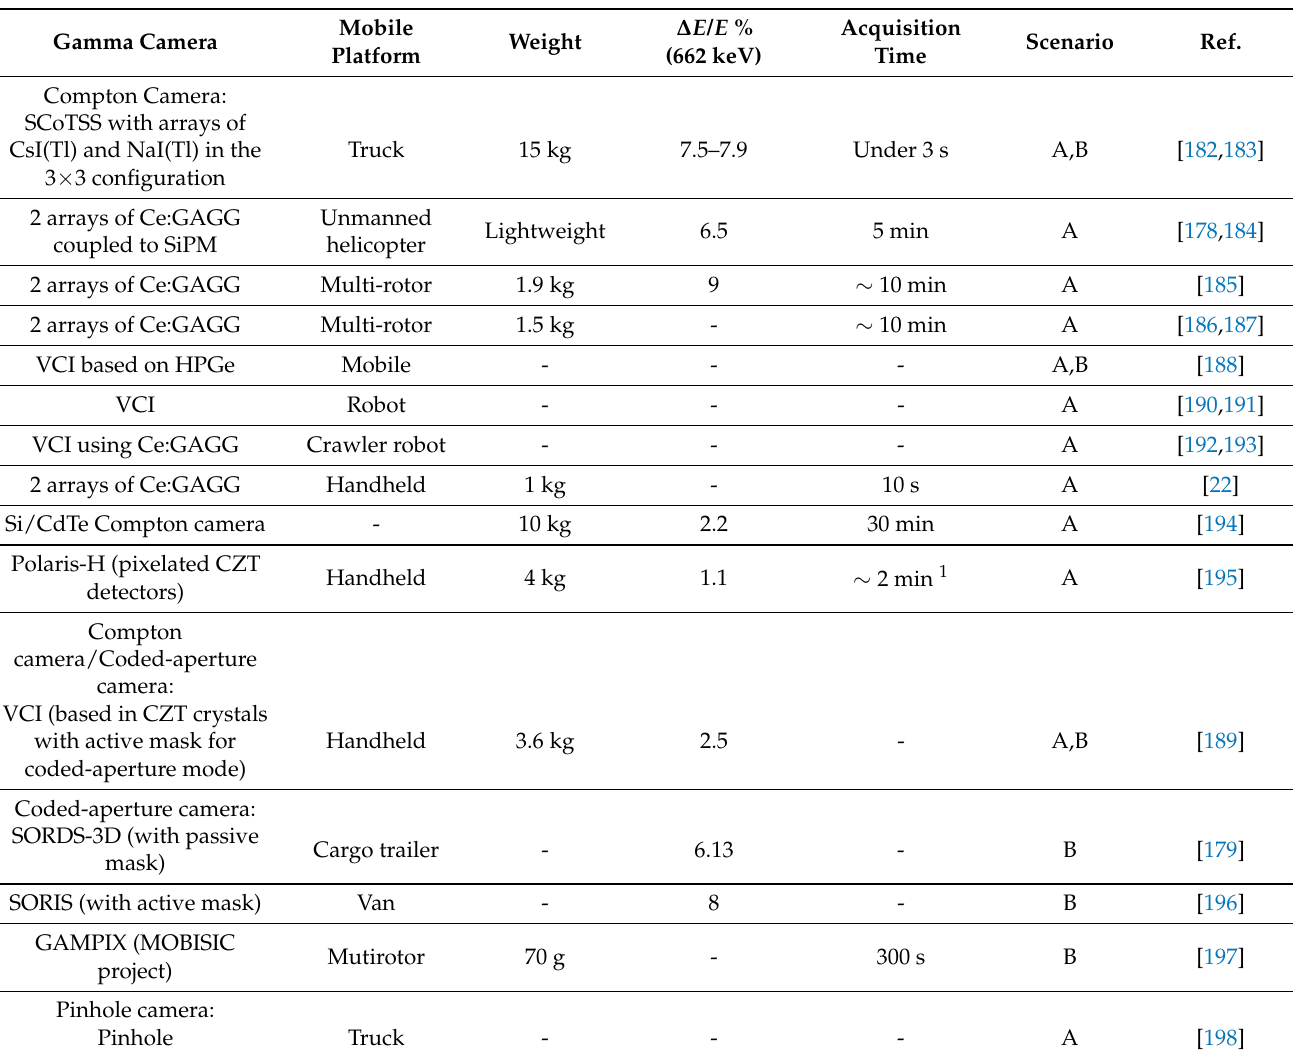
Table 8. Resume of the gamma cameras described in the literature considering the scenario types (described in Section 2). Gamma